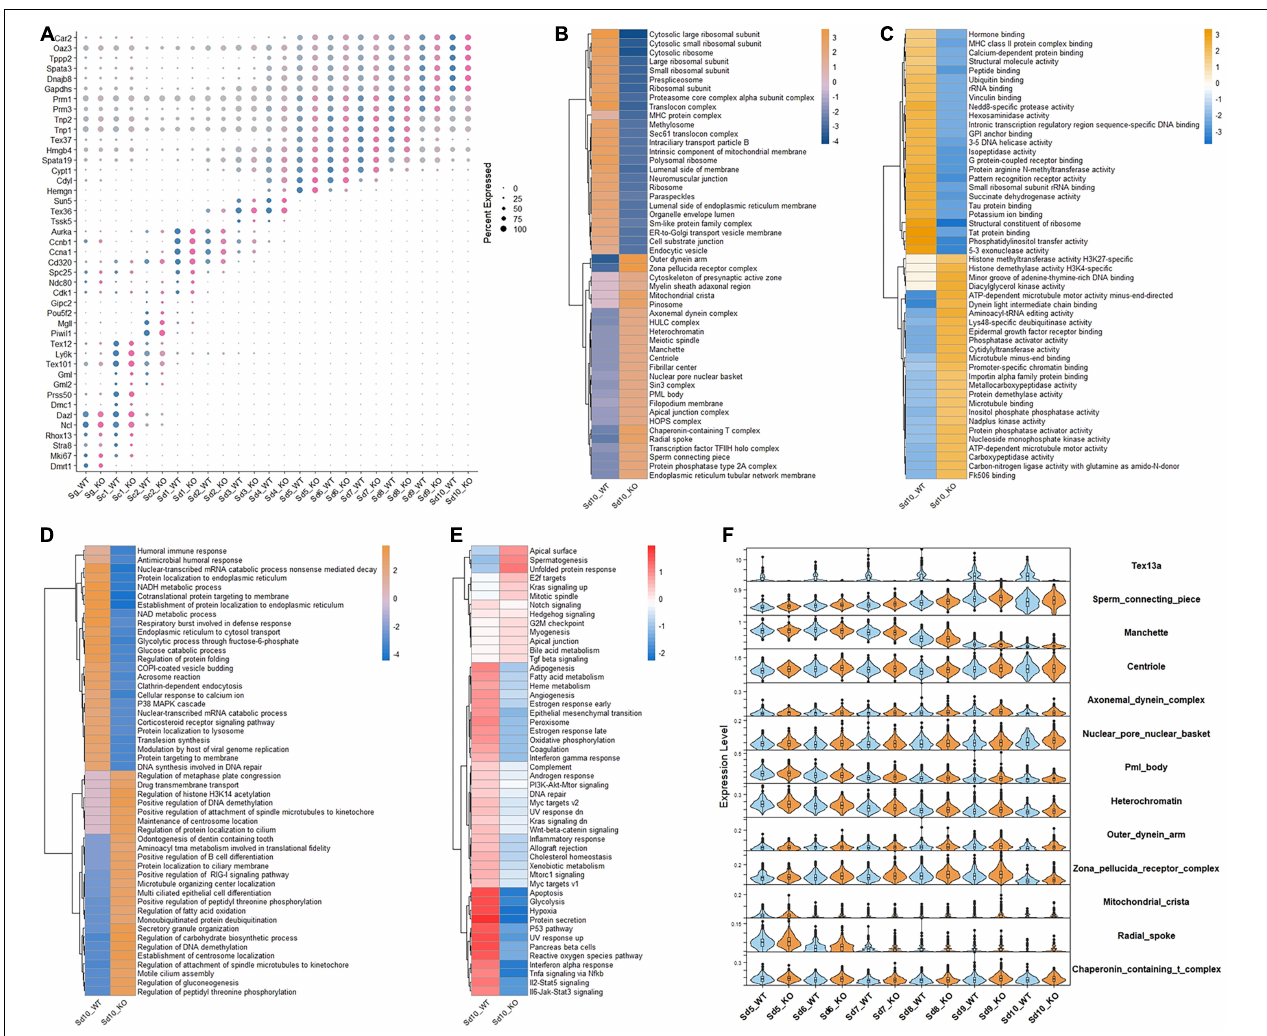
FIGURE 1 | The altered gene expression patterns in the elongating spermatids in Tex13-KO and WT mouse. (A) The cell markers of all the germ cell clusters in WT and Tex13a KO mouse testes. (B) Top 25 upregulated and downregulated pathways of C5 (CC) (GSEA) in elongating spermatid Sd10 from WT and Tex13a KO mouse testes. (C) Top 25 upregulated and downregulated pathways of C5 (MF) (GSEA) in elongating spermatid Sd10. (D) Top 25 upregulated and downregulated pathways of C5 (BP) (GSEA) in Sd10_WT and Sd10_KO. (E) The relative expression level of 50 hallmark signaling pathways (GSEA) in Sd10_WT and Sd10_KO. (F) The expression profiles in Sd5–Sd10 of selected upregulated pathways in